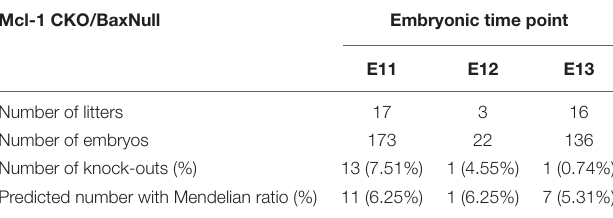
TABLE 1 | Survival of Mcl-1 CKO/BaxNull embryos.